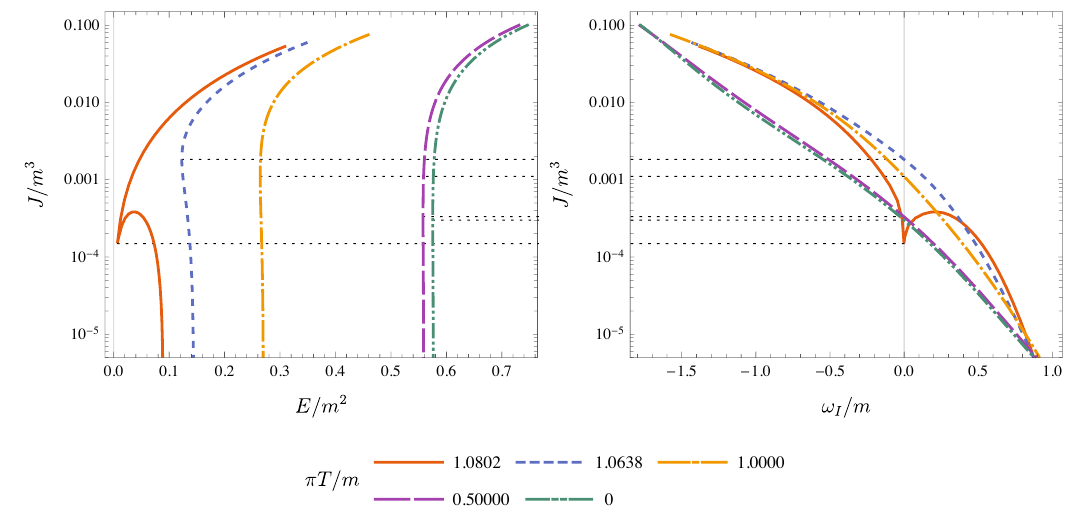
Figure 12 . (left) E – J curves at various temperatures. (right) Current J/m 3 as a function of the imaginary part of mode frequency ω I /m for the pure-imaginary mode. The horizontal dotted lines in the both panels show the first turning points of E – J curves at each temperatures, and these points completely match to points where ω I goes across